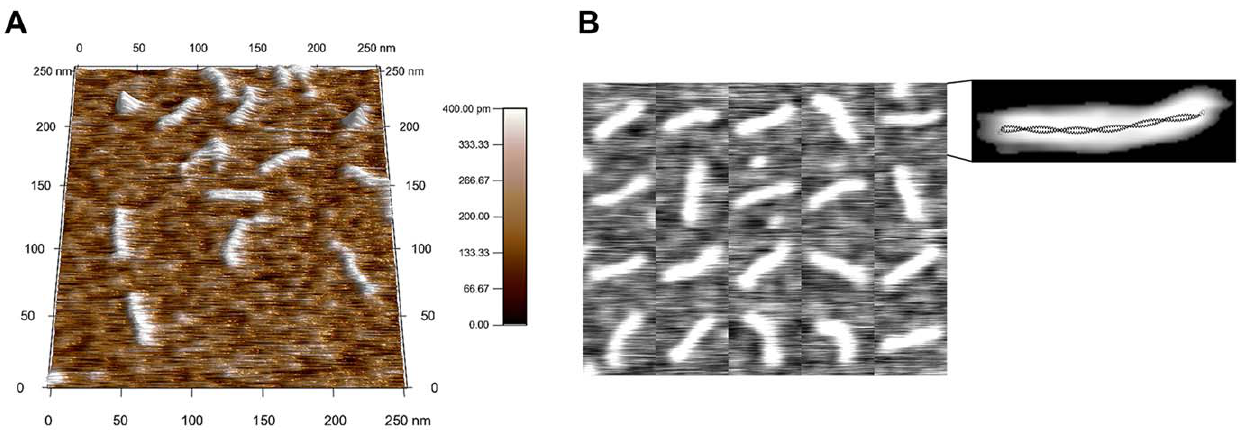
Figure 1. AFM images of a -tropomyosin ( a Tm) molecules. Wildtype human cardiac a Tm was imaged dry on poly-lysine coated mica (A). Collage of 20 a Tm molecules (B) show that molecular contours were smooth and continuous. One of the a Tm molecules in the collage was processed as described (Figure 2 C) and overlayed with the x-ray structure of a Tm [38] on the same scale (B, expanded on right), which is evidence that the AFM images were good representations of single a Tm molecules.